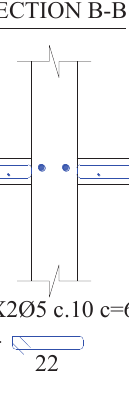
(b) Bottom longitudinal reinforcement